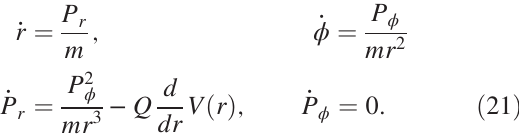
, r are shown for a min max